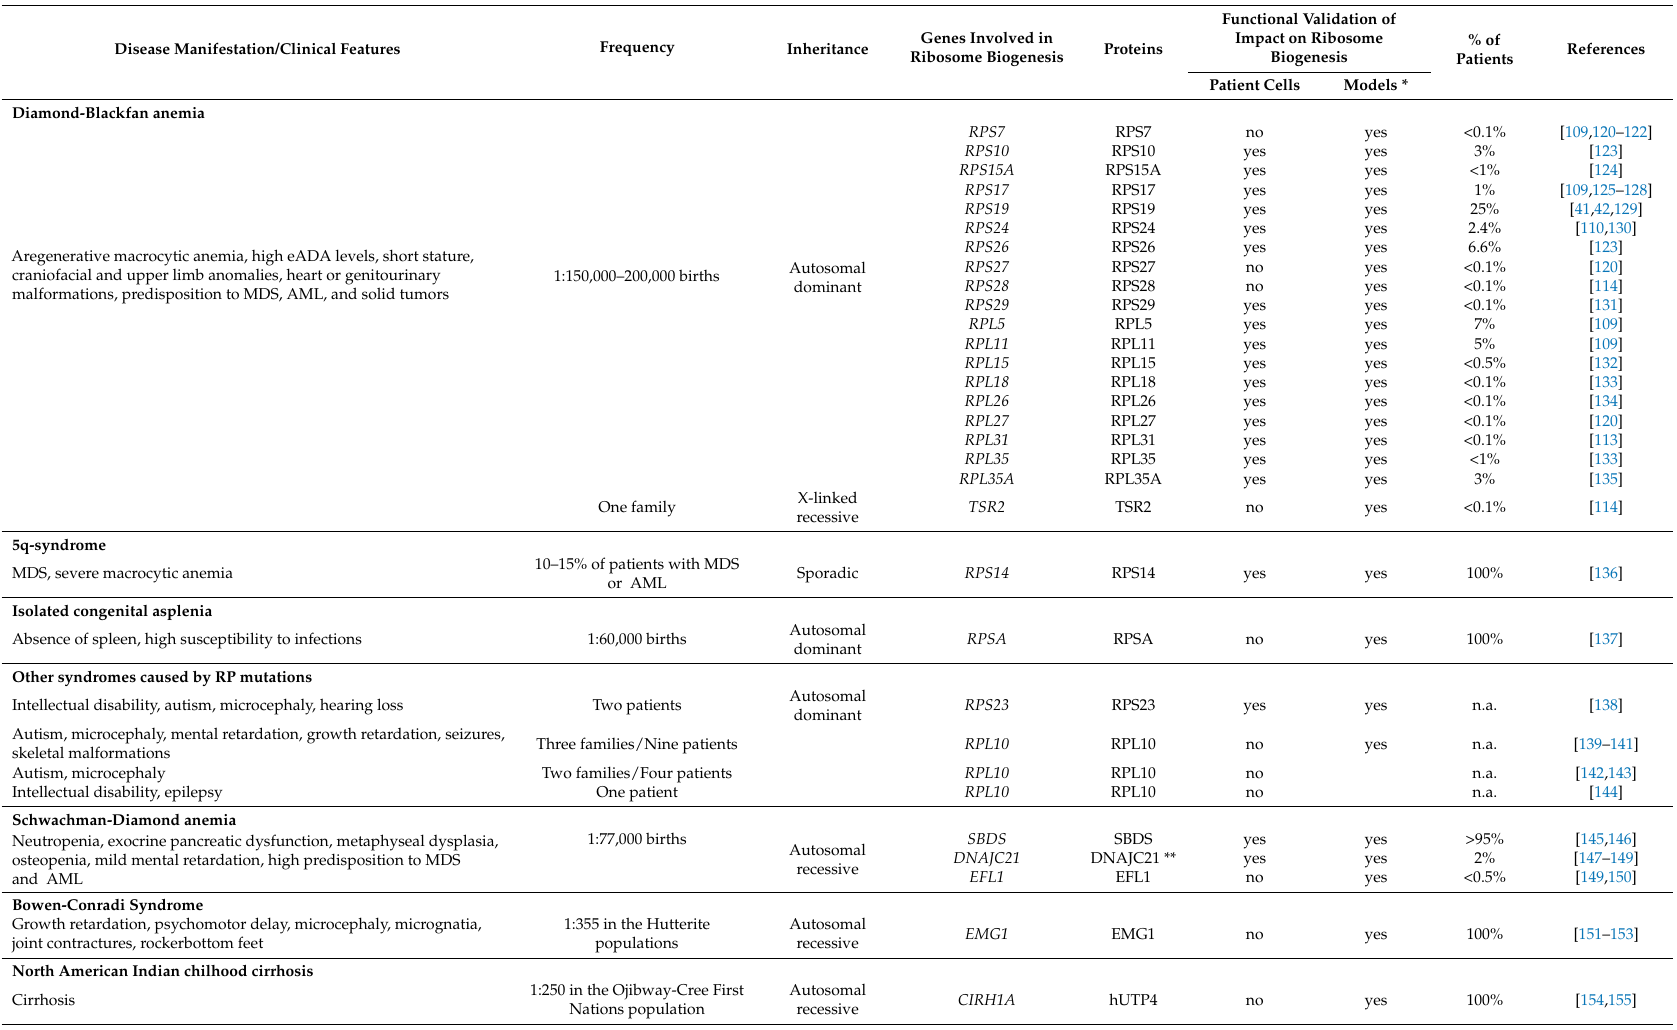
Table 1. Pathologies linked to mutations in genes encoding ribosomal proteins or ribosomal assembly factors